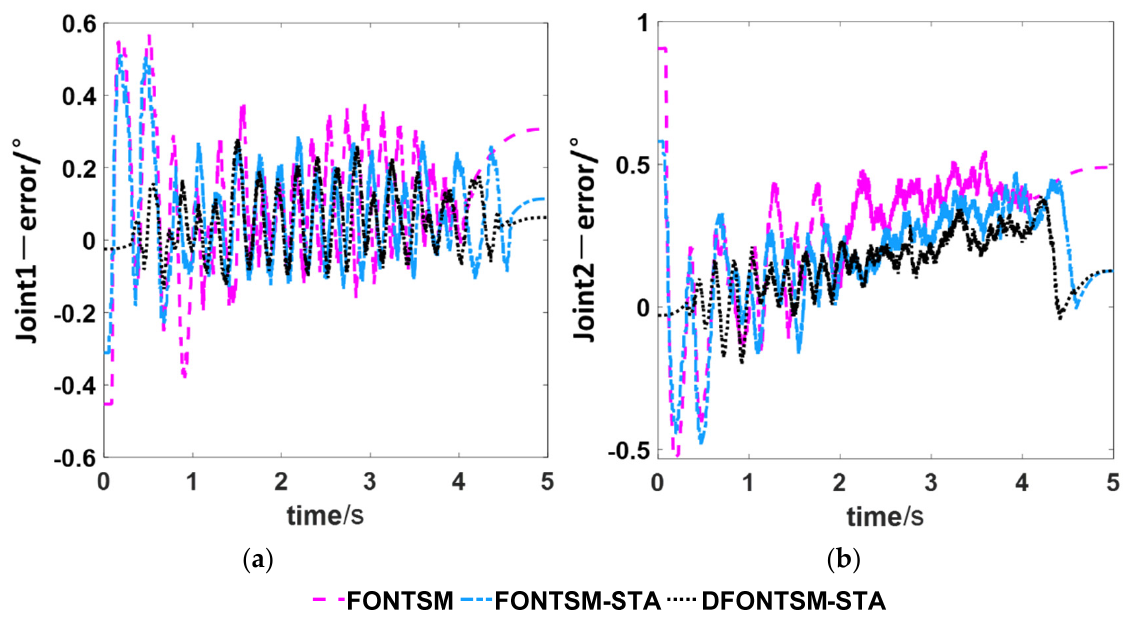
Figure 10. Position tracking errors of the shoulder joints. ( a ): joint one; ( b ): joint two.